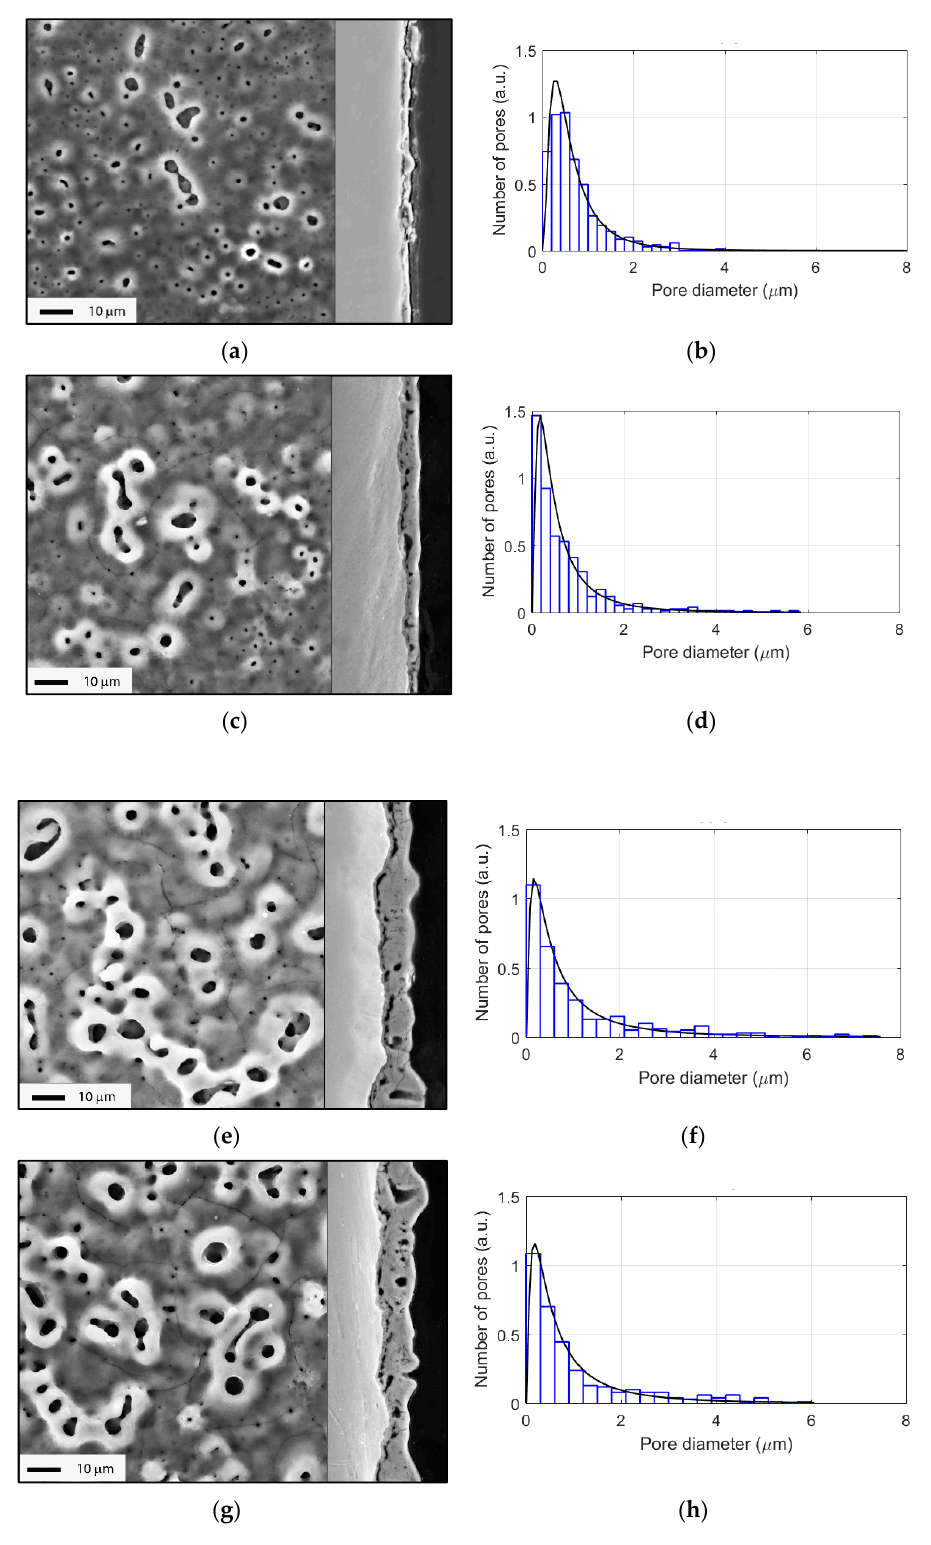
Figure 2. Surface morphology, coating cross-sections, and corresponding pore size distributions (with lognormal distribution fit) for the different PEO treatment times: ( a , b ) 45 s; ( c , d ) 60 s; ( e , f ) 90 s; ( g , h ) 120 s.